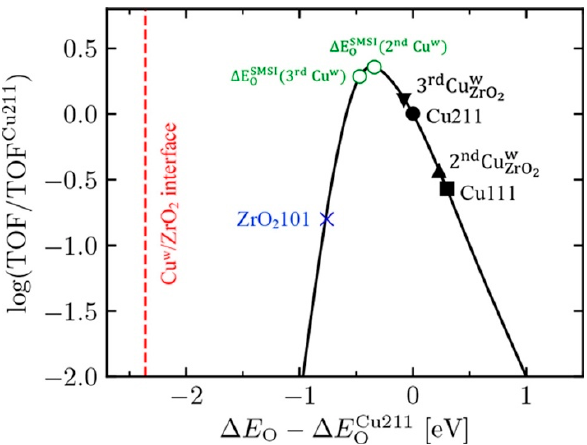
Figure 5. Theoretical activity volcano plot for the hydrogenation of CO 2 to methanol [85]. (https://pubs.acs.org/doi/10.1021/acs.jpcc.9b06500). Reprinted with the permission of the American Chemical Society, further permissions related to the material excerpted should be directed to the ACS.